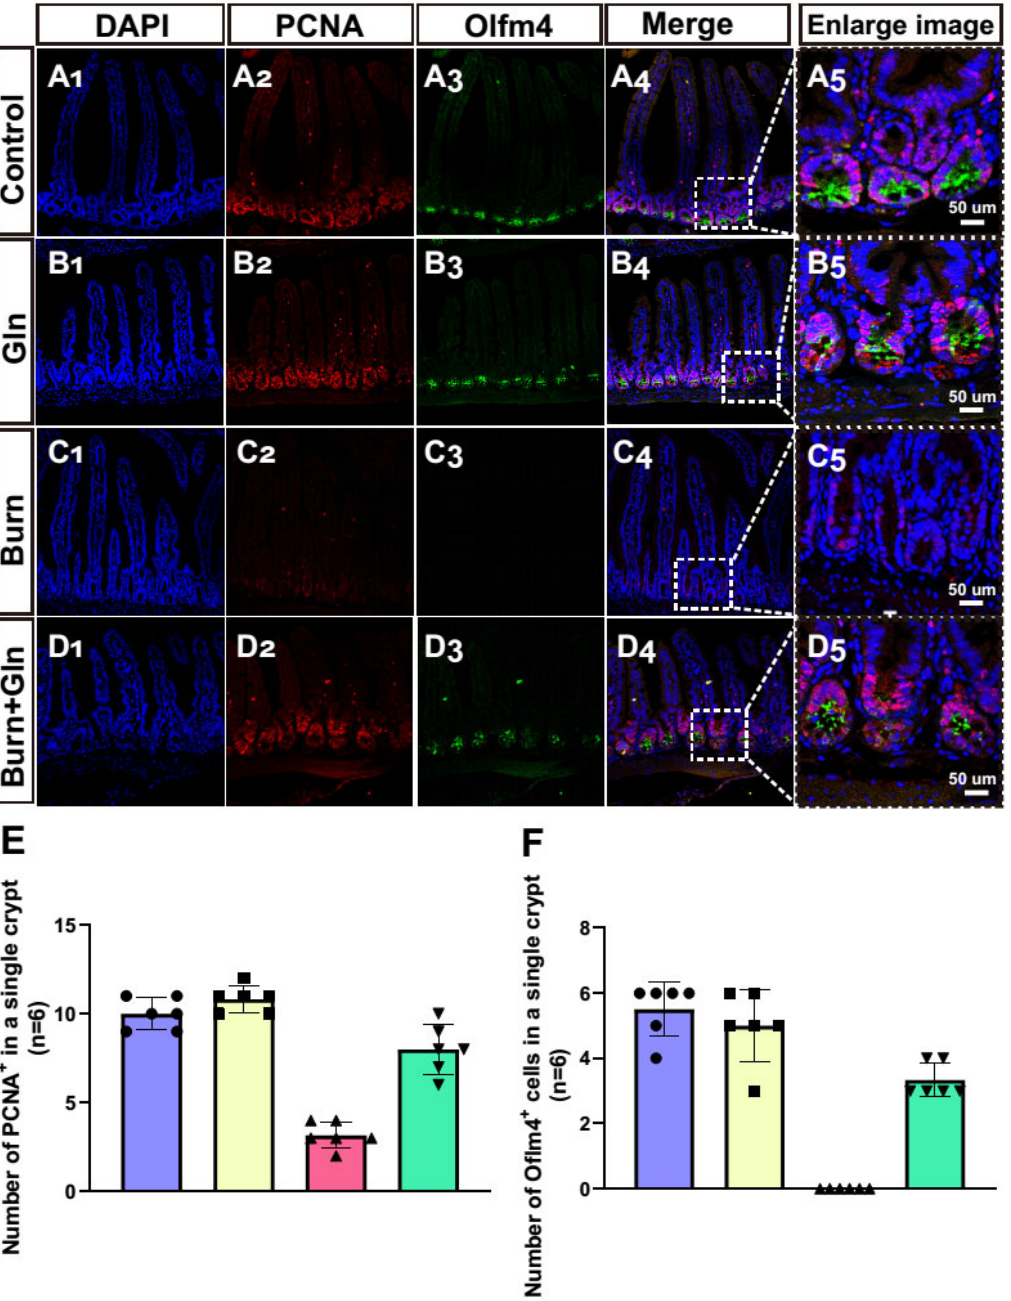
Figure 4. Influences of Gln treatment on proliferation and stemness of small intestinal crypts and ISCs of C57 mice after burn injury. ( A – C ) Representative images of immunofluorescence for proliferation cell nuclear antigen (PCNA) (red), olfactomedin 4 (Olfm4) (green), and DAPI (blue) in different groups: ( A 1 – A 5 ) Control group. ( B 1 – B 5 ) Gln group. ( C 1 – C 5 ) Burn group. ( D 1 – D 5 ) Burn+Gln group. ( E ) Comparison of the number of PCNA-positive cells in a single crypt in different groups. ( F ) Comparison of the number of Olfm4-positive cells in a single crypt in different groups. Data were expressed as mean ± SEM from 6 independent experiments ( n = 6).